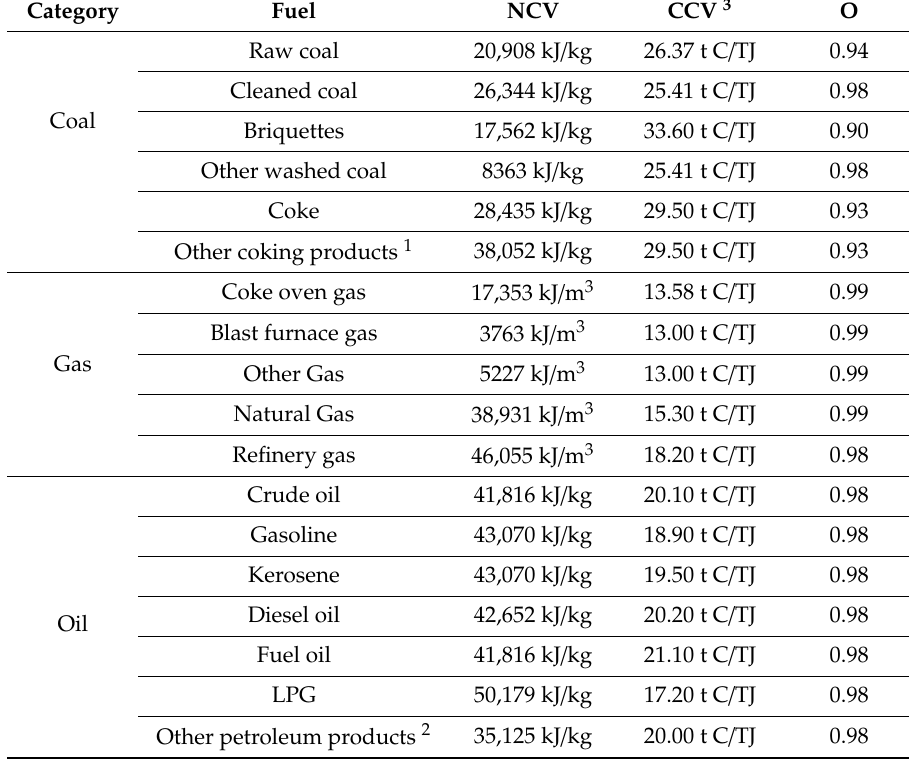
Table 2. Parameters for Calculating Carbon